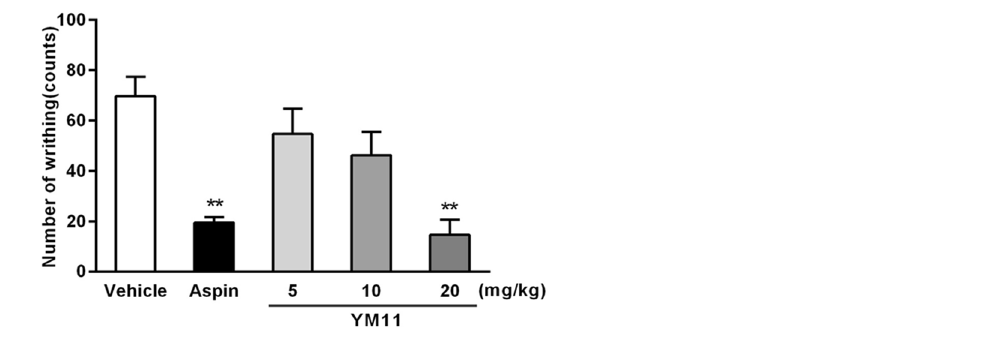
Figure 3. Analgesic effect of YM 11 on acetic acid-induced writhing response in mice. Results were expressed as mean ± SEM (n = 10). ** P < 0.01 vs . vehicle.